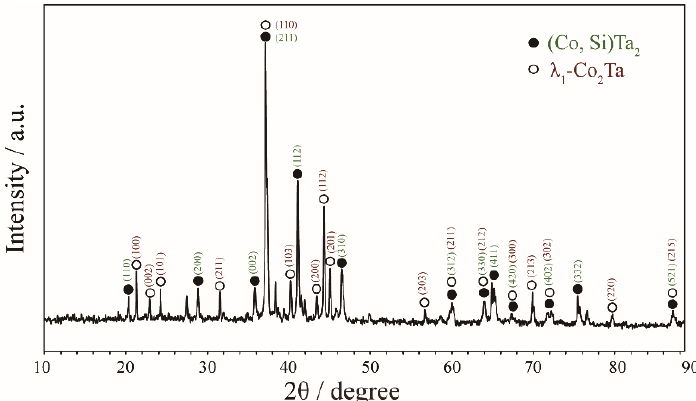
Figure 5. XRD patterns obtained of Co 30 Ta 43 Si 27 alloy annealed at 1100 °C for 60 days.